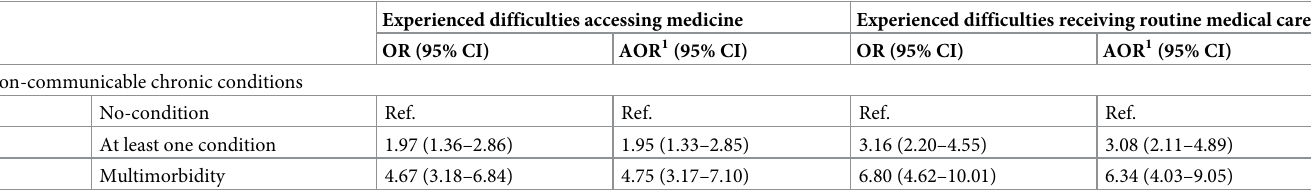
Table 4. Association between multimorbidity, presence of any NCD conditions and difficulties receiving medication and health care among Bangladeshi older adults during